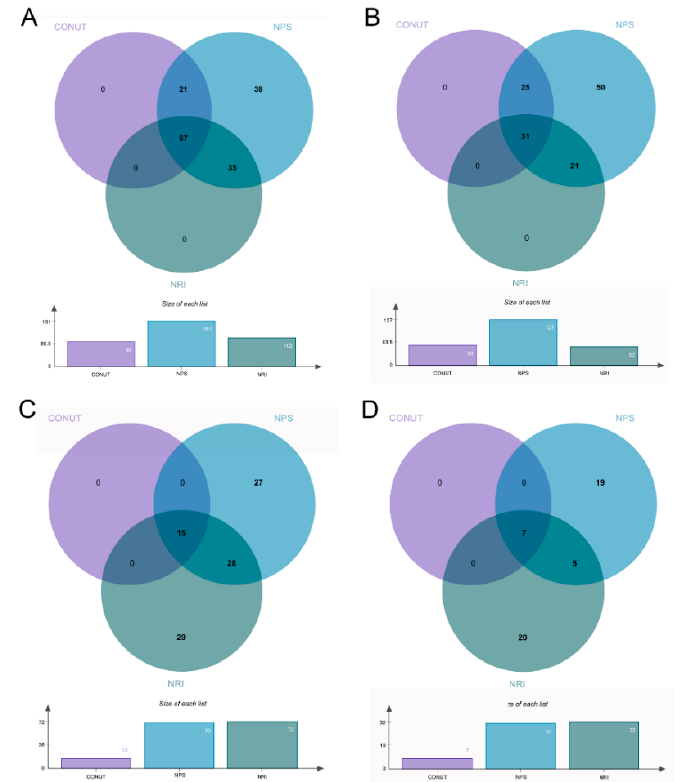
Figure 2. Any degree of malnutrition or moderate-to-severe malnutrition identified by different definitions at 1st stage ( A , B ) and 2nd stage ( C , D ). CONUT, Controlling Nutritional Status; NRI, Nutritional Risk Inde; NPS, Naples Prognostic Score.